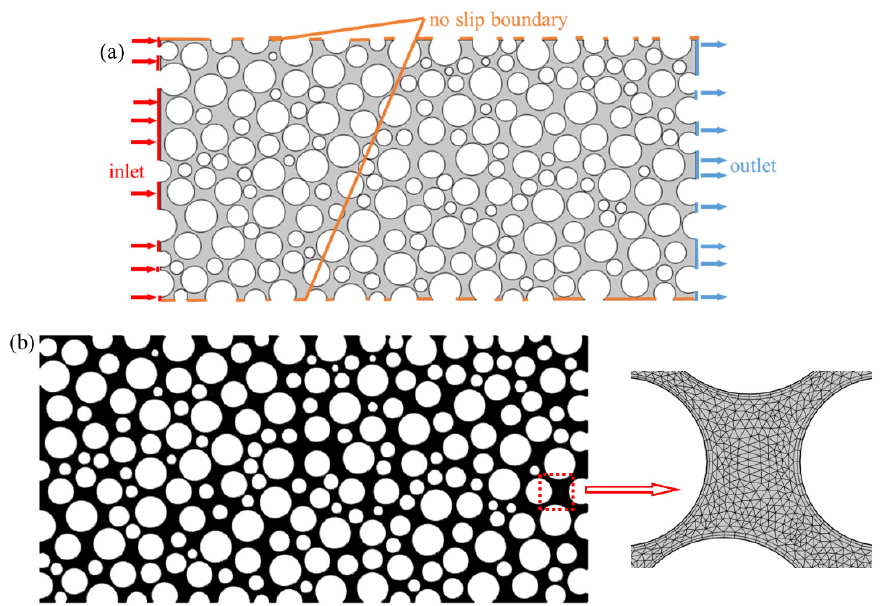
Figure 3. Schematic diagram of the 2D geometric model and its mesh model. ( a ) Schematic diagram of the geometric model and initial and boundary conditions for numerical simulations; ( b ) Schematic diagram of mesh model.